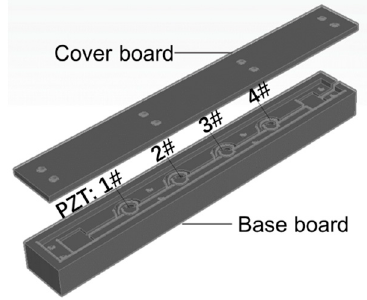
Figure 3. The structure of the piezoelectric array system.